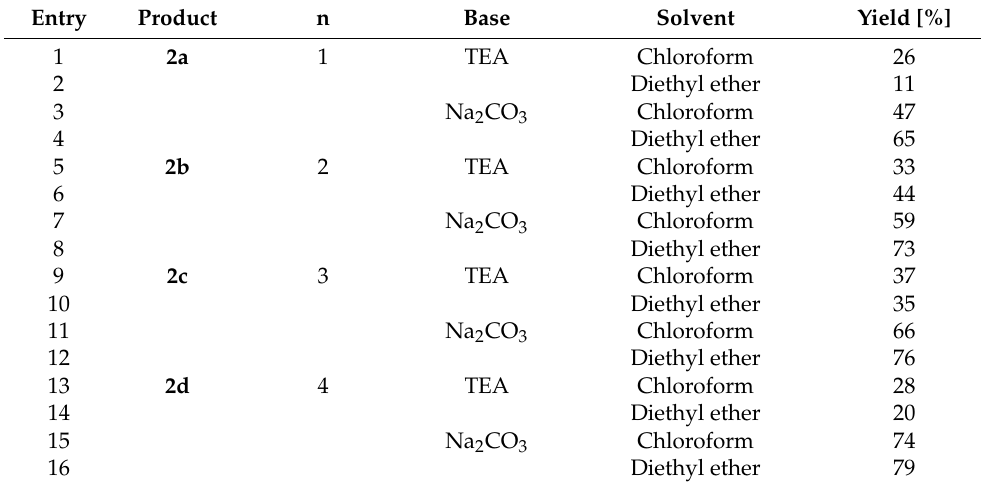
Table 1. N , N ′ -Diacylhydrazines ( 2a – d ) derived from acid chlorides. Table 1. N , N (cid:48) -Diacylhydrazines ( 2a – d ) derived from acid chlorides.